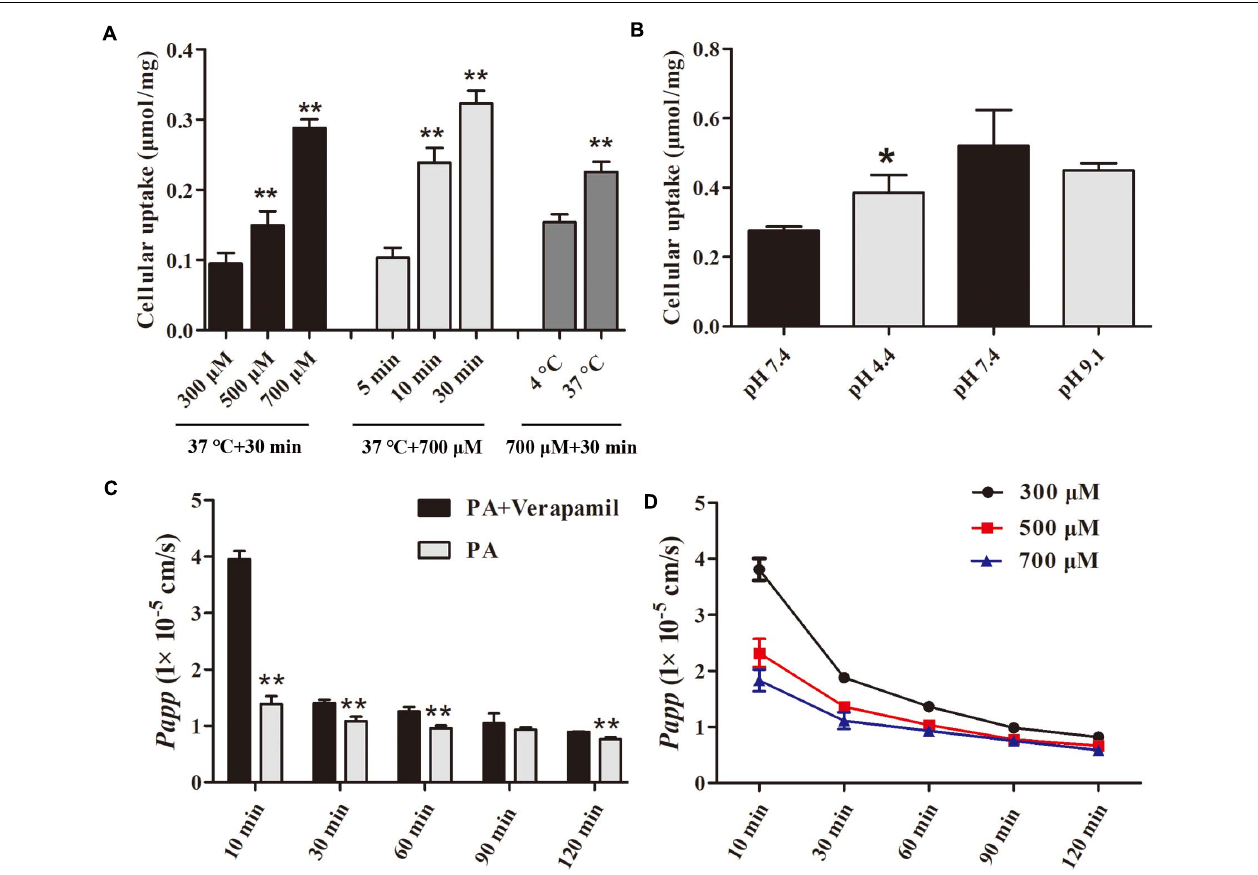
FIGURE 8 | Uptake and transport of PA in Caco-2 monolayers. (A, B) Effect of concentrations, time, temperature, and pH on uptake of PA by Caco-2 cells. (C, D) Effect of time, efflux transporter inhibitor, and concentrations on transport of PA by Caco-2 cells. The data were expressed as the mean ± SD ( n = 4). * P < 0.05 and ** P < 0.01, compared with control group.